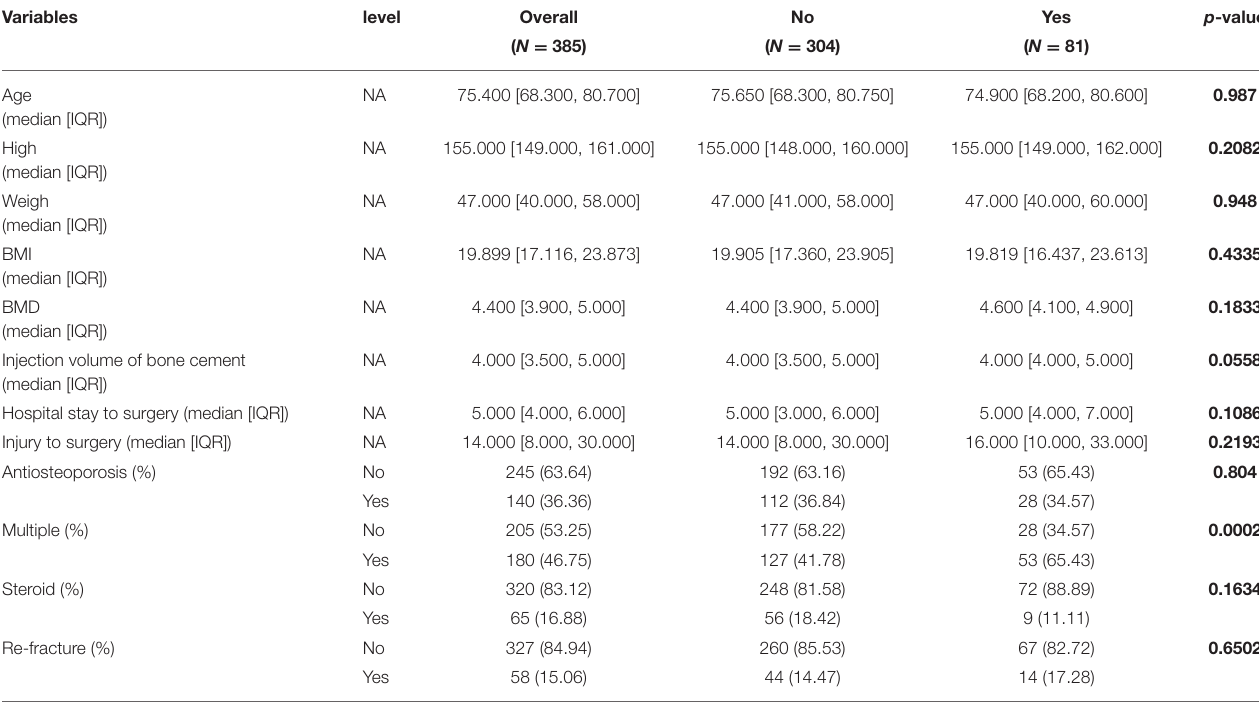
TABLE 1 | Baseline table of patients with and without cement leakage.